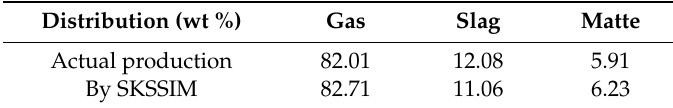
Table 2. Arsenic fractional distribution among gas, matte and slag